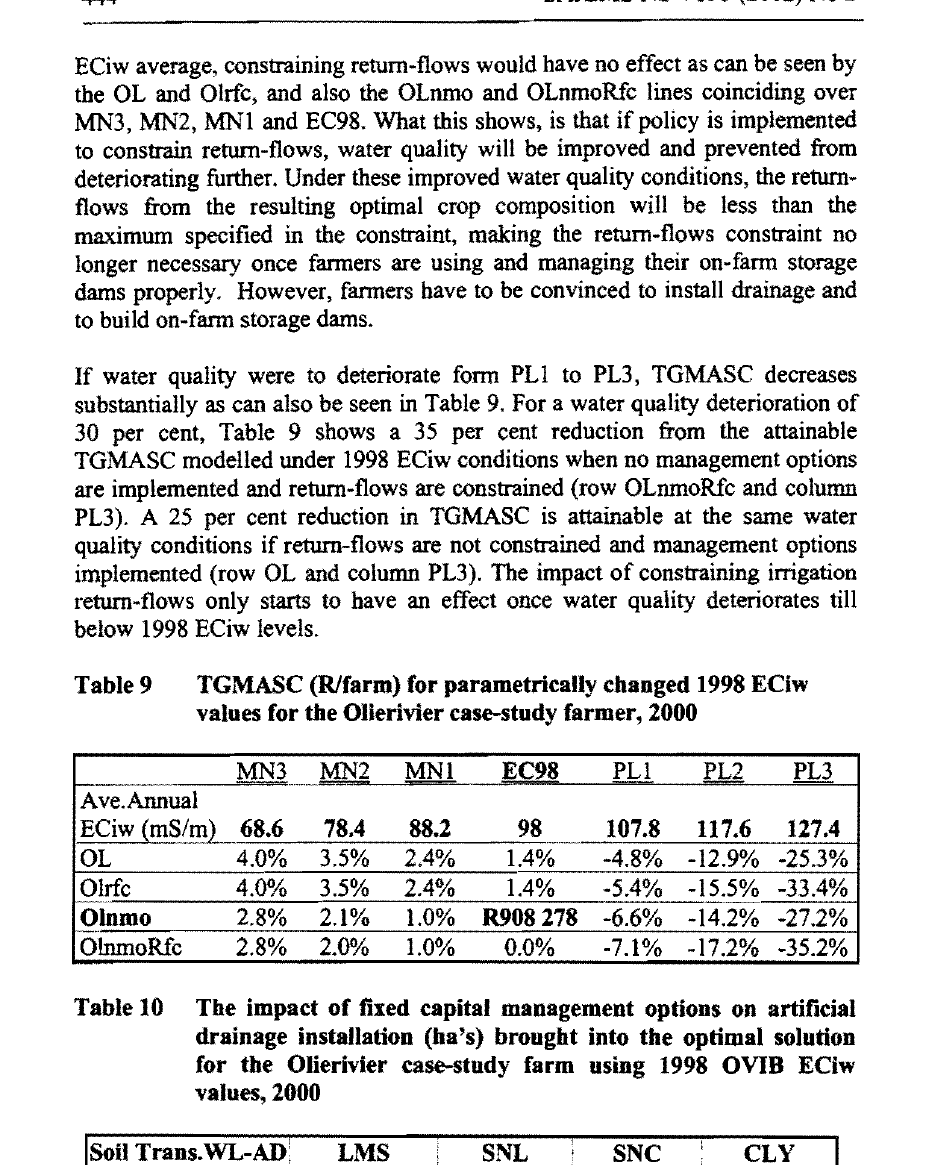
TGMASC (RIfarm) for parametrically changed 1998 ECiw values for the Olierivier case-study farmer, 2000 MN3